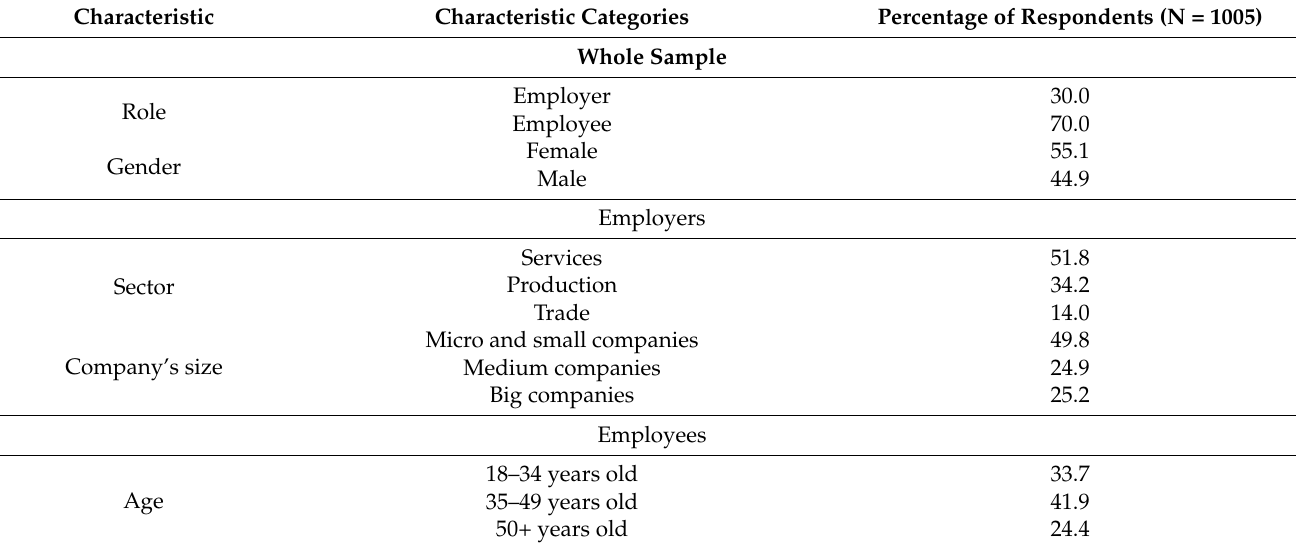
Table 1. Sample structure in the CATI research.